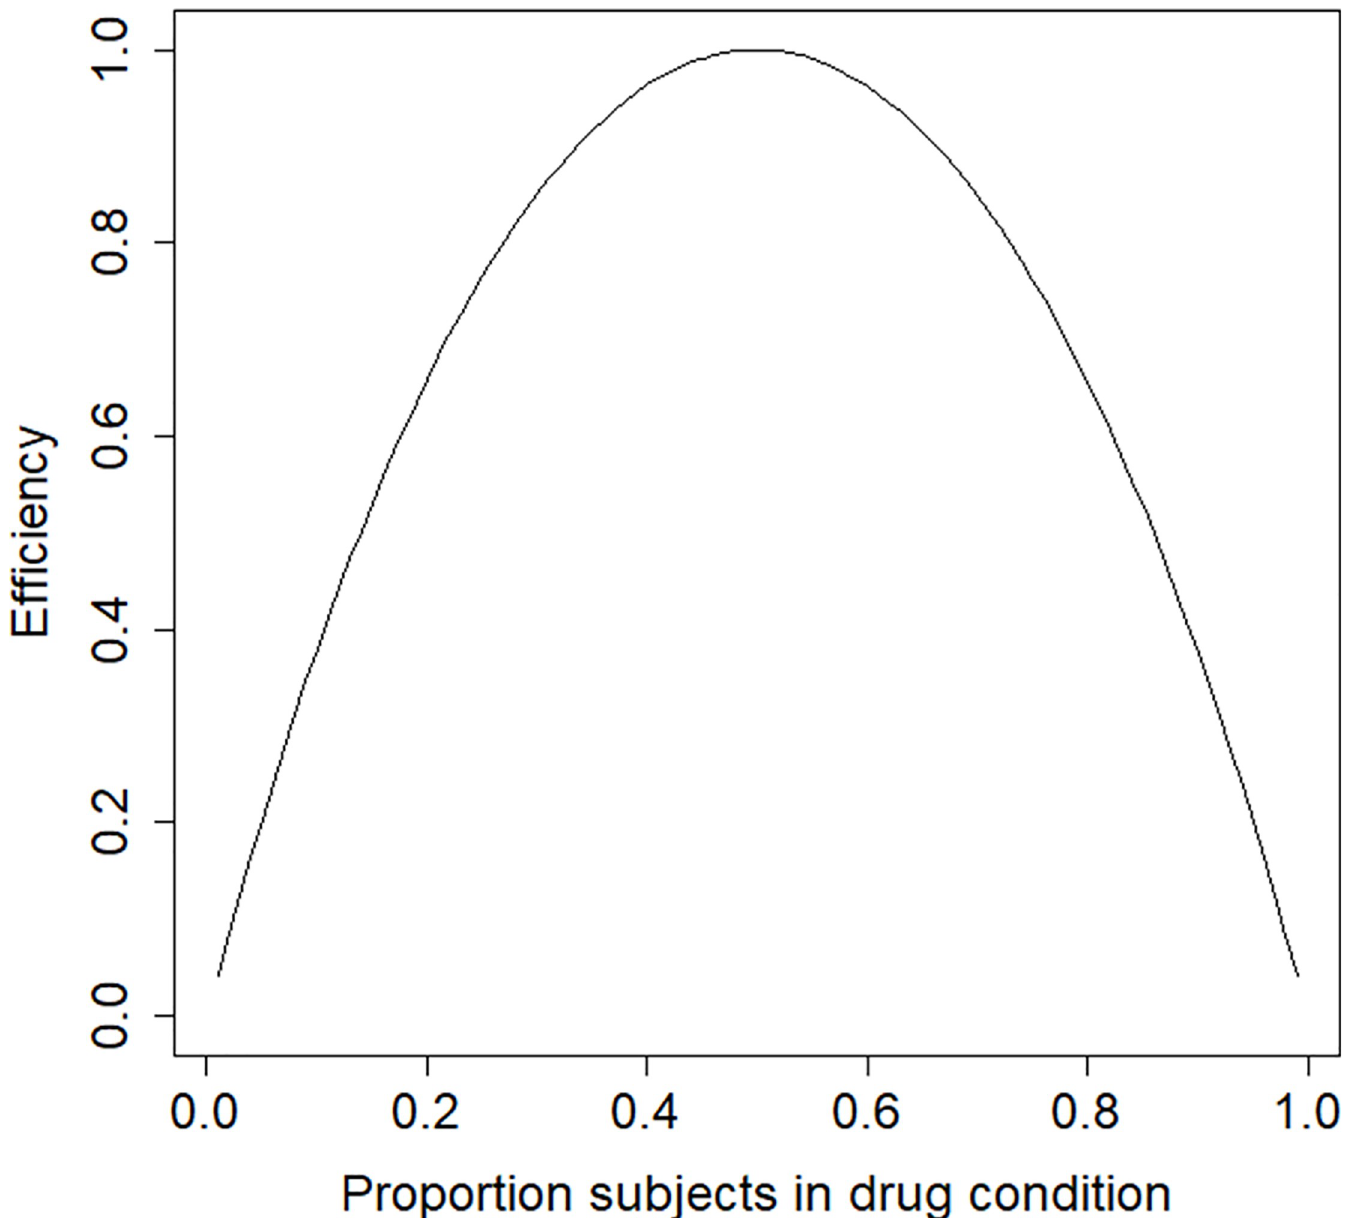
Fig 3. Efficiency graph for the schizophrenia